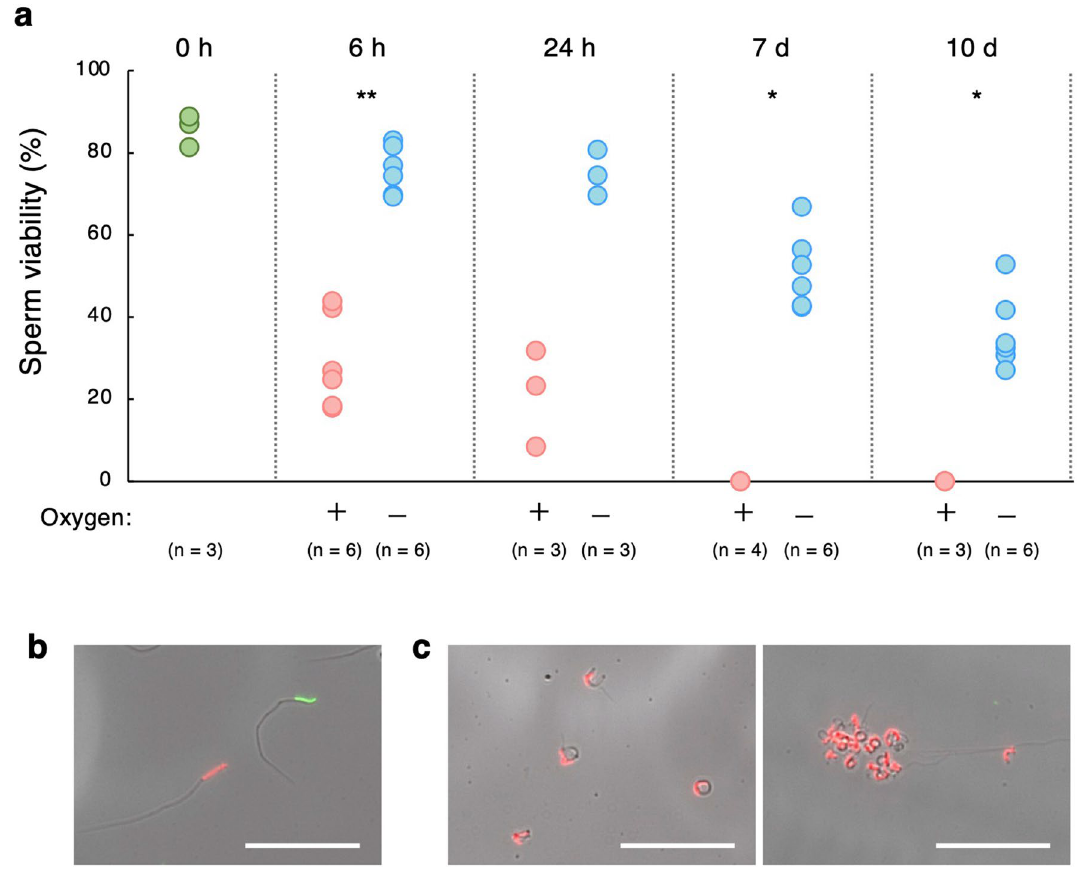
Figure 7. ( a ) Sperm viability under aerobic (+) and anoxic (after adding sodium sulfite) (−) PBS conditions. Asterisks indicate statistical significance based on Mann–Whitney U tests (* p < 0.05, ** p < 0.005). ( b ) Image of surviving sperm stained green and dead sperm stained red under artificially anoxic conditions for 7 days. ( c ) Images of dead sperm cells with abnormal shape (left), and sperm aggregation (right). Scale bars indicate 50